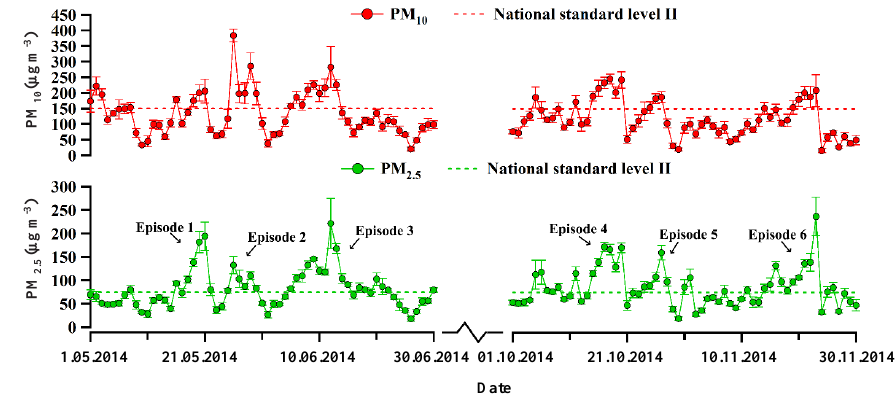
Figure 2. Daily concentrations of PM 10 and PM 2 . 5 in May, June, October, and November 2014. Episode 1, 16 to 22 May; episode 2, 25 to 30 May; episode 3, 5 to 15 June; episode 4, 15 to 20 October; episode 5, 24 to 28 October; Episode 6, 14 to 23 November. Table 1. Comparisons of PM 10 and PM 2 . 5 (in µgm − 3 ) between Wuhan and other Chinese cities and regions. PM 10 PM 2 . 5 Sampling